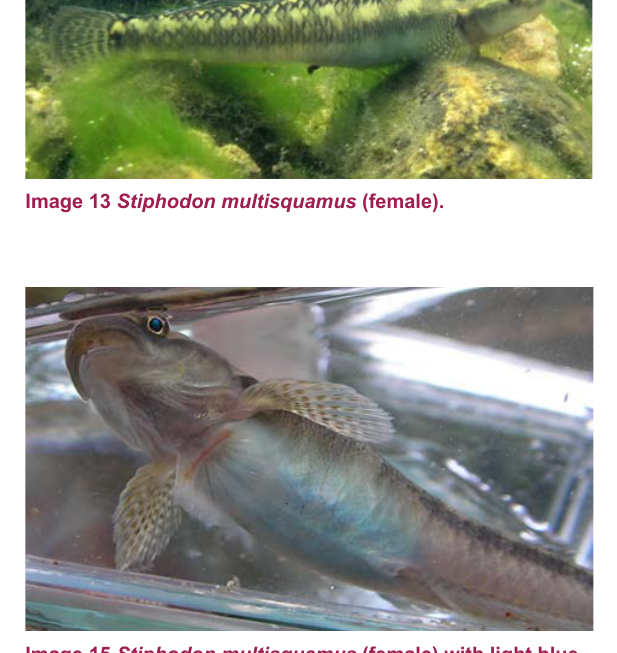
(no female was identified in the present study, description is based on illustration from Nakabo (2000)). Sicyopus zosterophorum : D1: VI, D2: I-9, A: I-10, P: 15. The species ranges from 3-5 cm in TL. Male: anterior half of body dark grey and brown/ yellowish brown, posterior half yellow, green and orange; two thick dark bars on anterior half of body, two more dark bars below second dorsal fin and one dark bar on caudal peduncle (Image 18). Female: body light brown without obvious stripe or bar (Image 19).